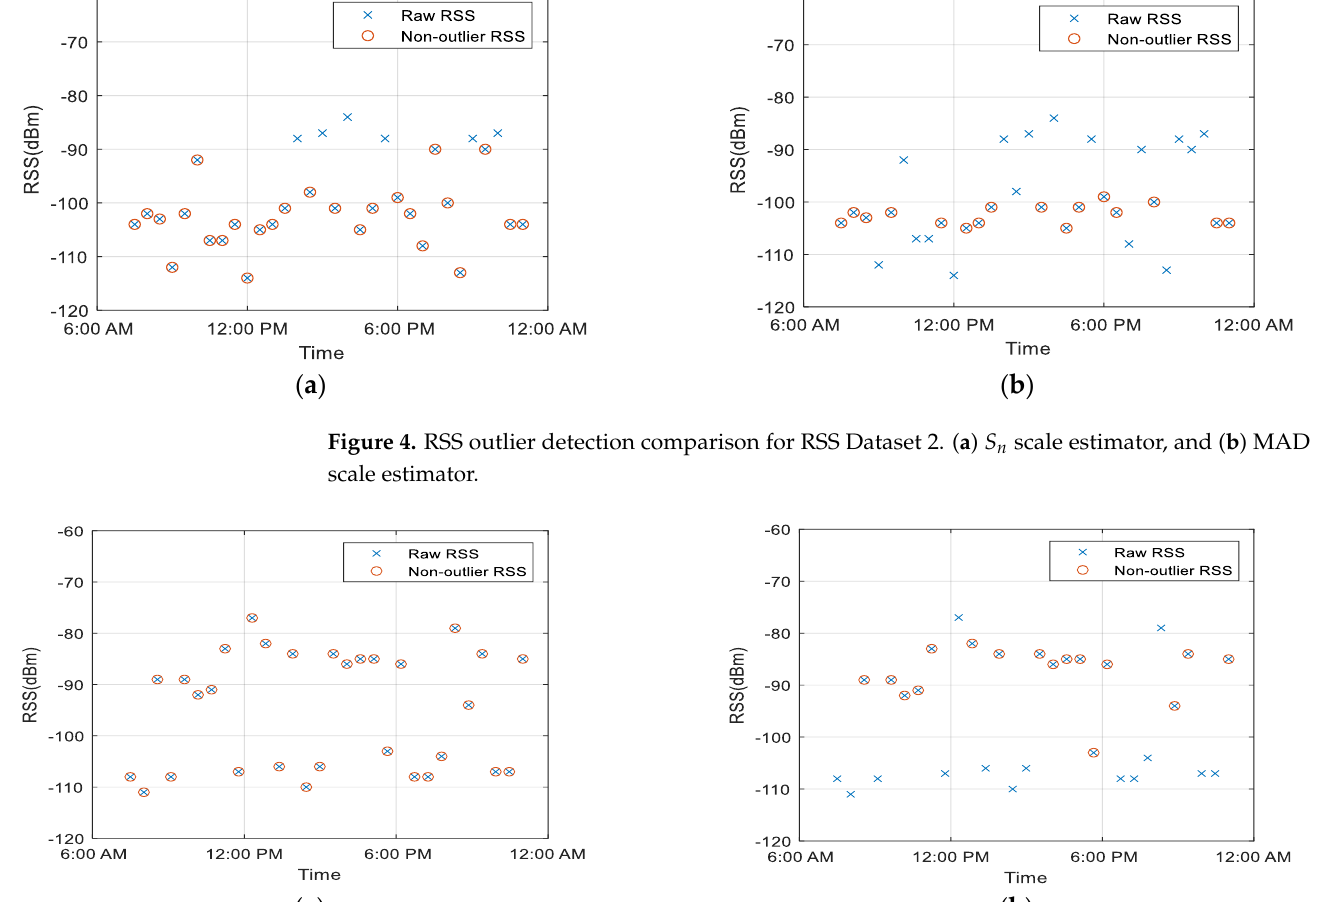
Figure 3. RSS outlier detection comparison for RSS Dataset 1. ( a ) 𝑆 𝑛 scale estimator, and ( b ) MAD scale estimator.